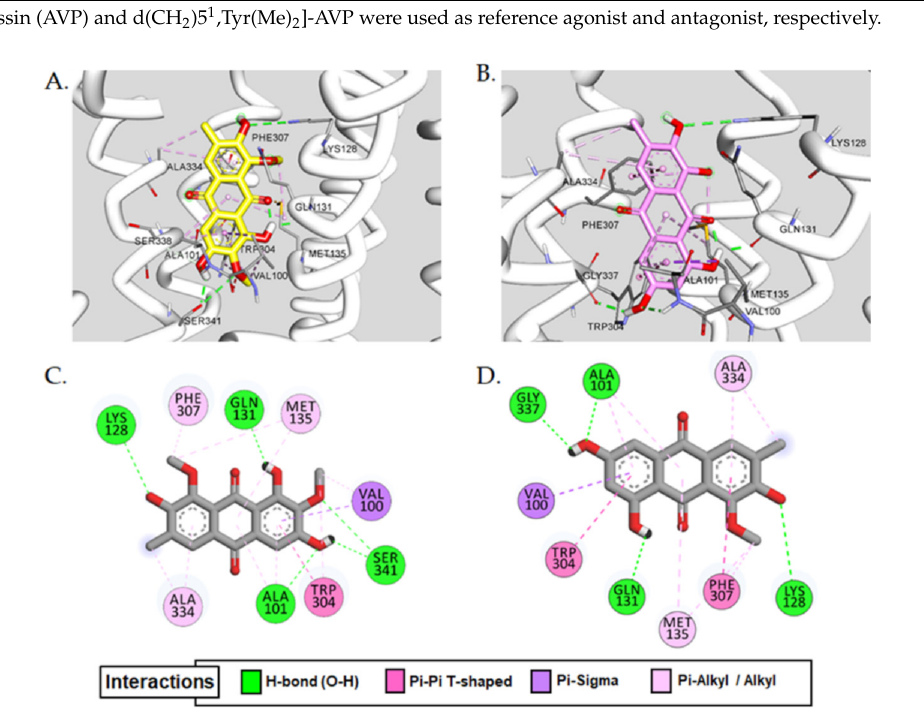
Figure 3. Interaction of ( A ) aurantio-obtusin (yellow) and ( B ) 2-hydroxyemodin 1-methylether (pink) in the active site of vasopressin V 1A receptor (V 1A R). ( C , D ) represent 2D-binding diagrams of aurantio-obtusin and 2-hydroxyemodin 1-methylether in V 1A R, respectively. Dotted-colored lines represent interaction types—green: H-bond interaction; maroon: π - π T-shaped; purple: π -sigma; pink: π -alkyl/alkyl